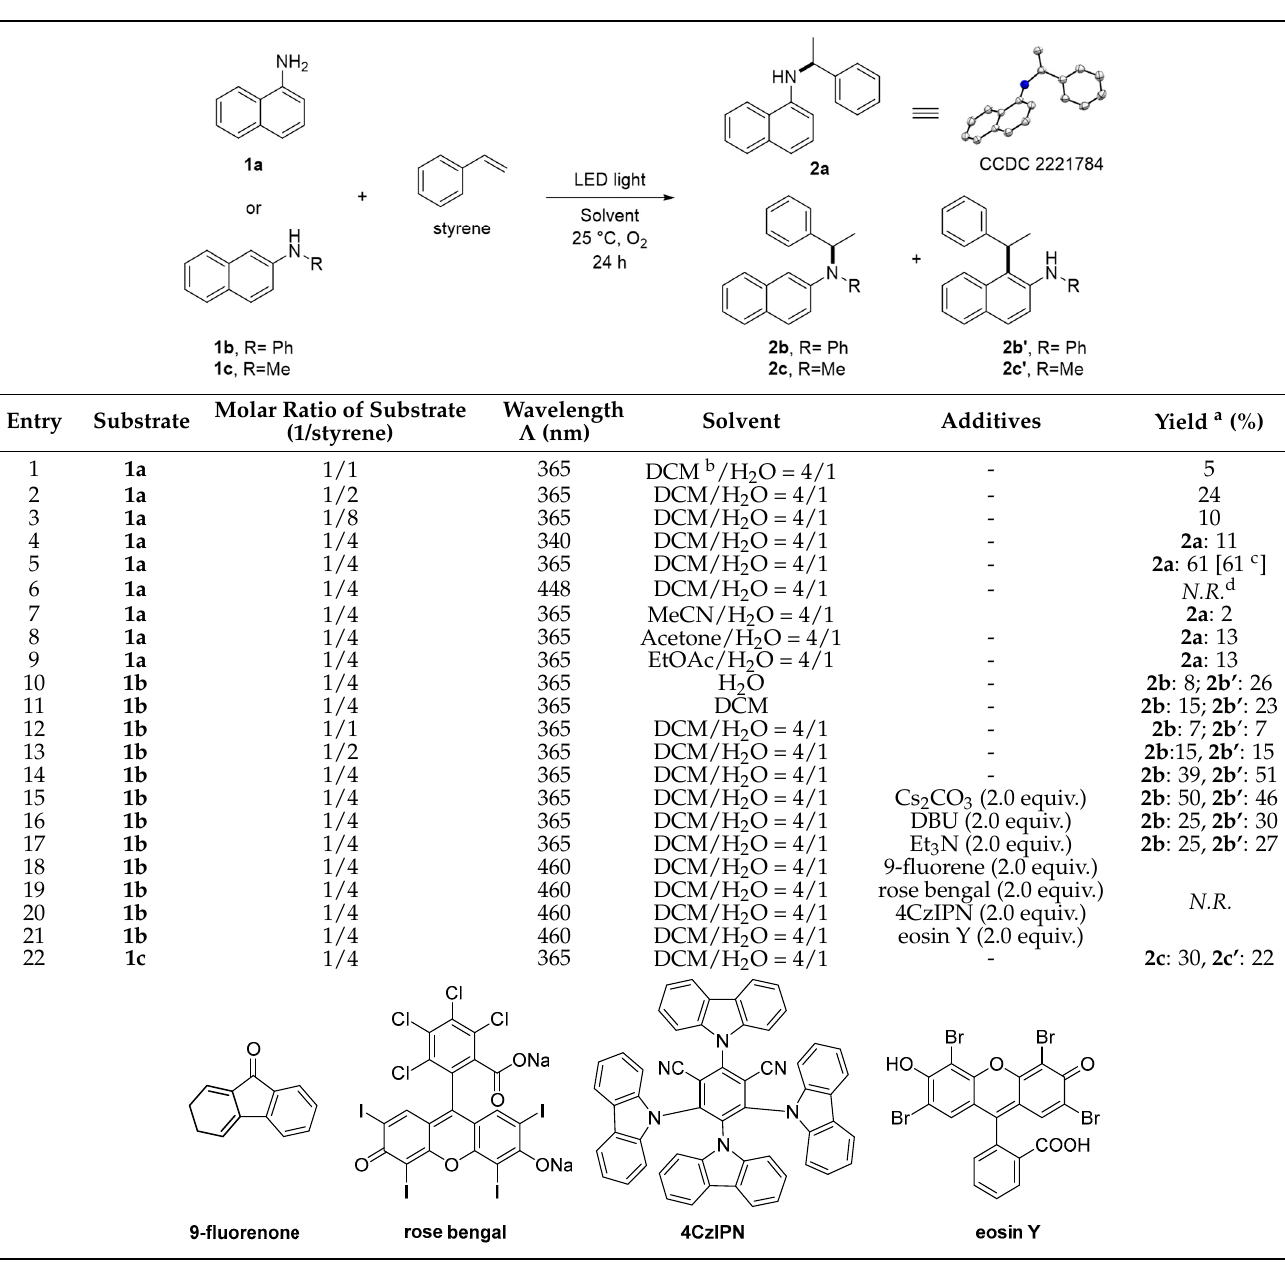
Table 1. Optimization of reaction conditions.